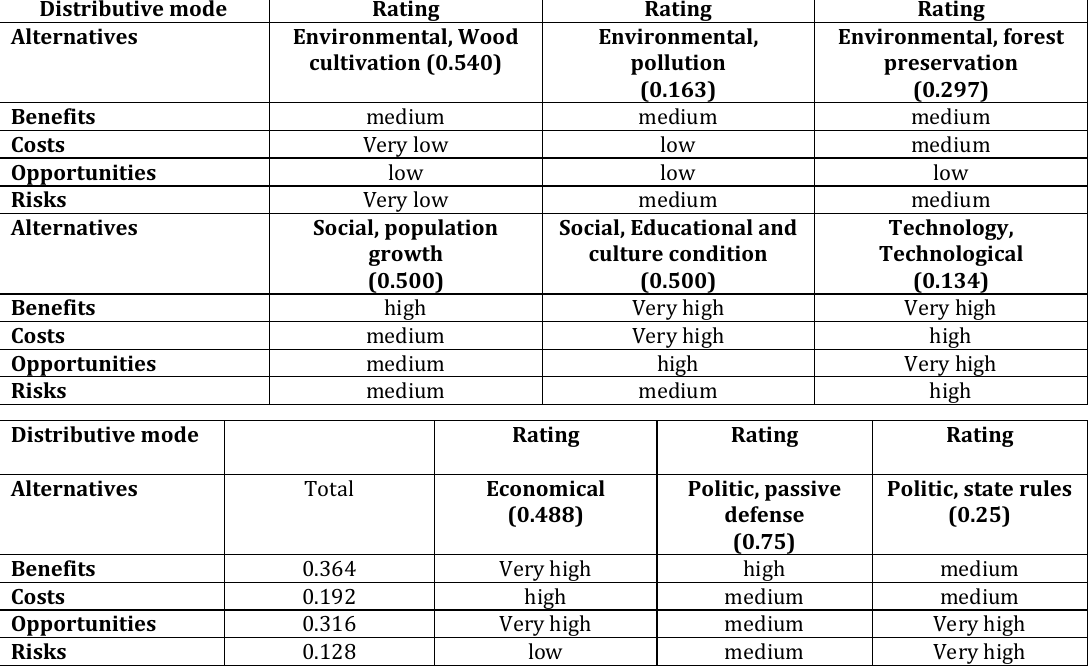
Table 8: The ranking of BOCR indicators by E.C software very high (1), high (0.51), medium (0.252), low (0.124), very low